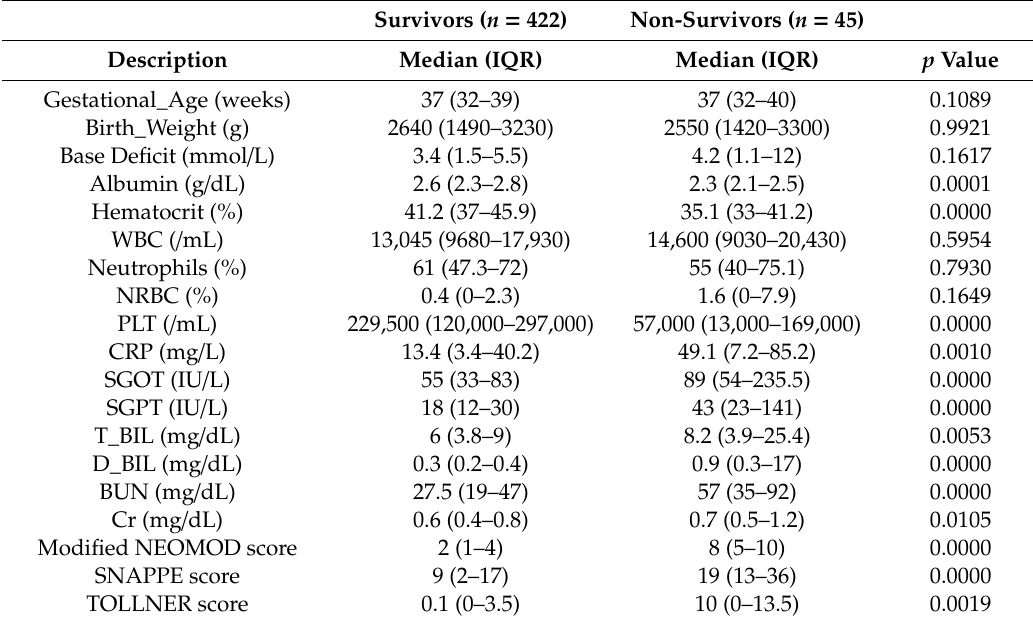
Table 3. Baseline characteristics and laboratory data of survivors vs.